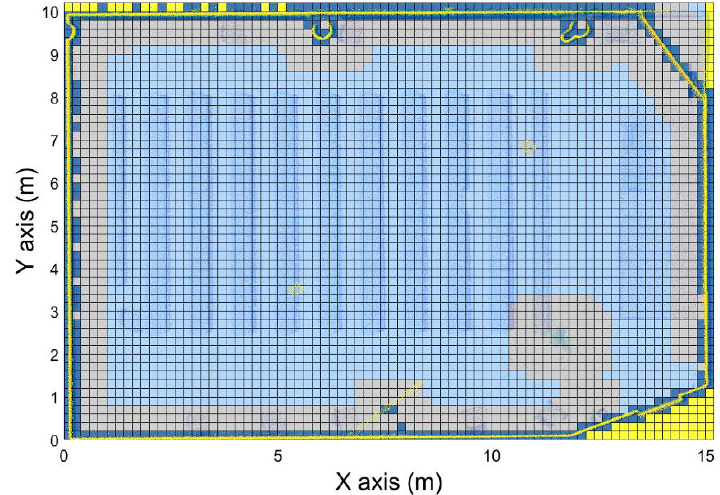
Figure 10. Horizontal plane of voxels. Light blue: Empty voxels. Dark blue: Occupied voxels. Grey: Security-offset voxels. Yellow: Exterior voxels.